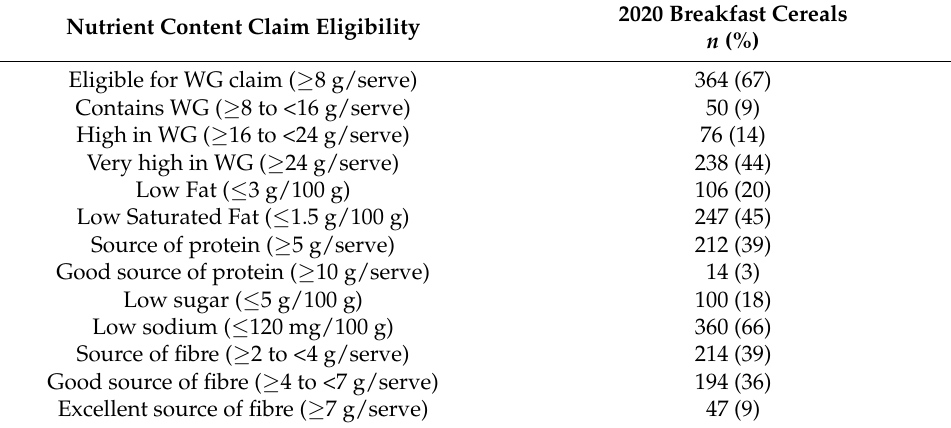
Table 3. Number and proportion of breakfast cereals meeting claim criteria in 2020 ( n =